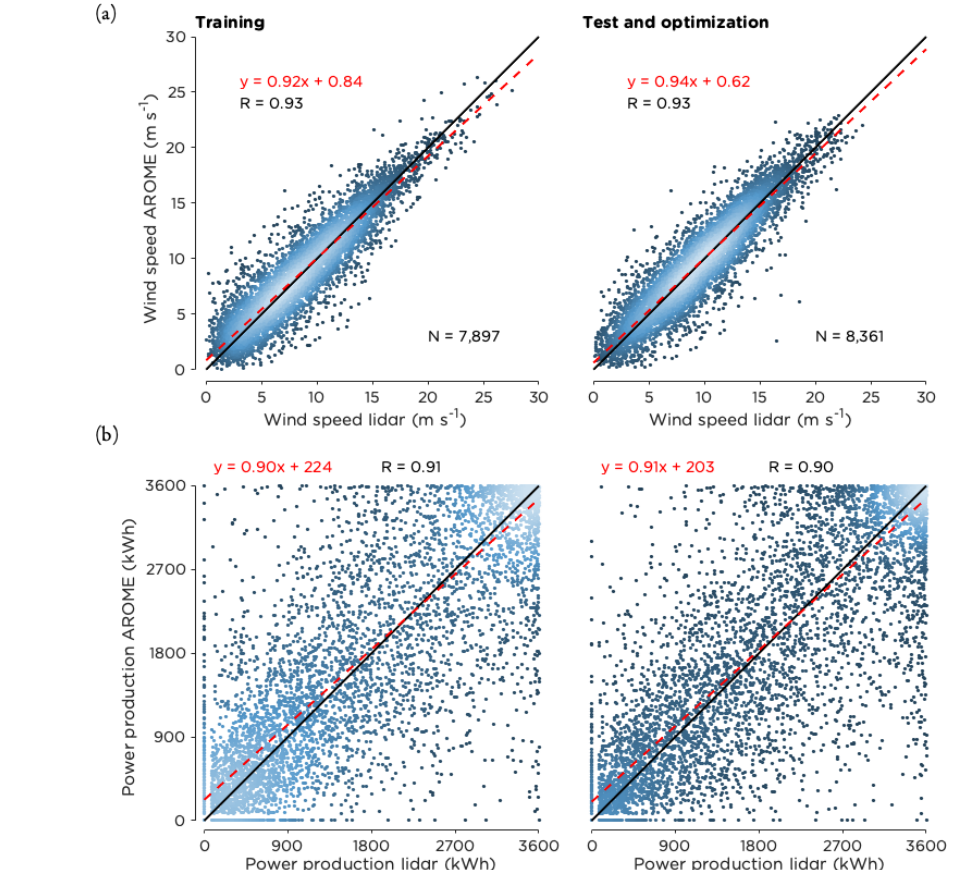
Figure 5. Scatter plots of (a) wind speed at hub height and (b) power production comparing the lidar data with the deterministic D1 forecasts from AROME during the 2 years analyzed. The black line is the 1 : 1 ratio, and the dashed line in red is the best linear fit to the data. The equation for the best fit is given together with the correlation coefficient ( R ) and the number of data points ( N ). The coloring of the data points indicate the density of the data with brighter colors representing higher density. Table 2. Feature appearance in order of selection based on improvement of MAE skill score for the optimization period for the three tested RF